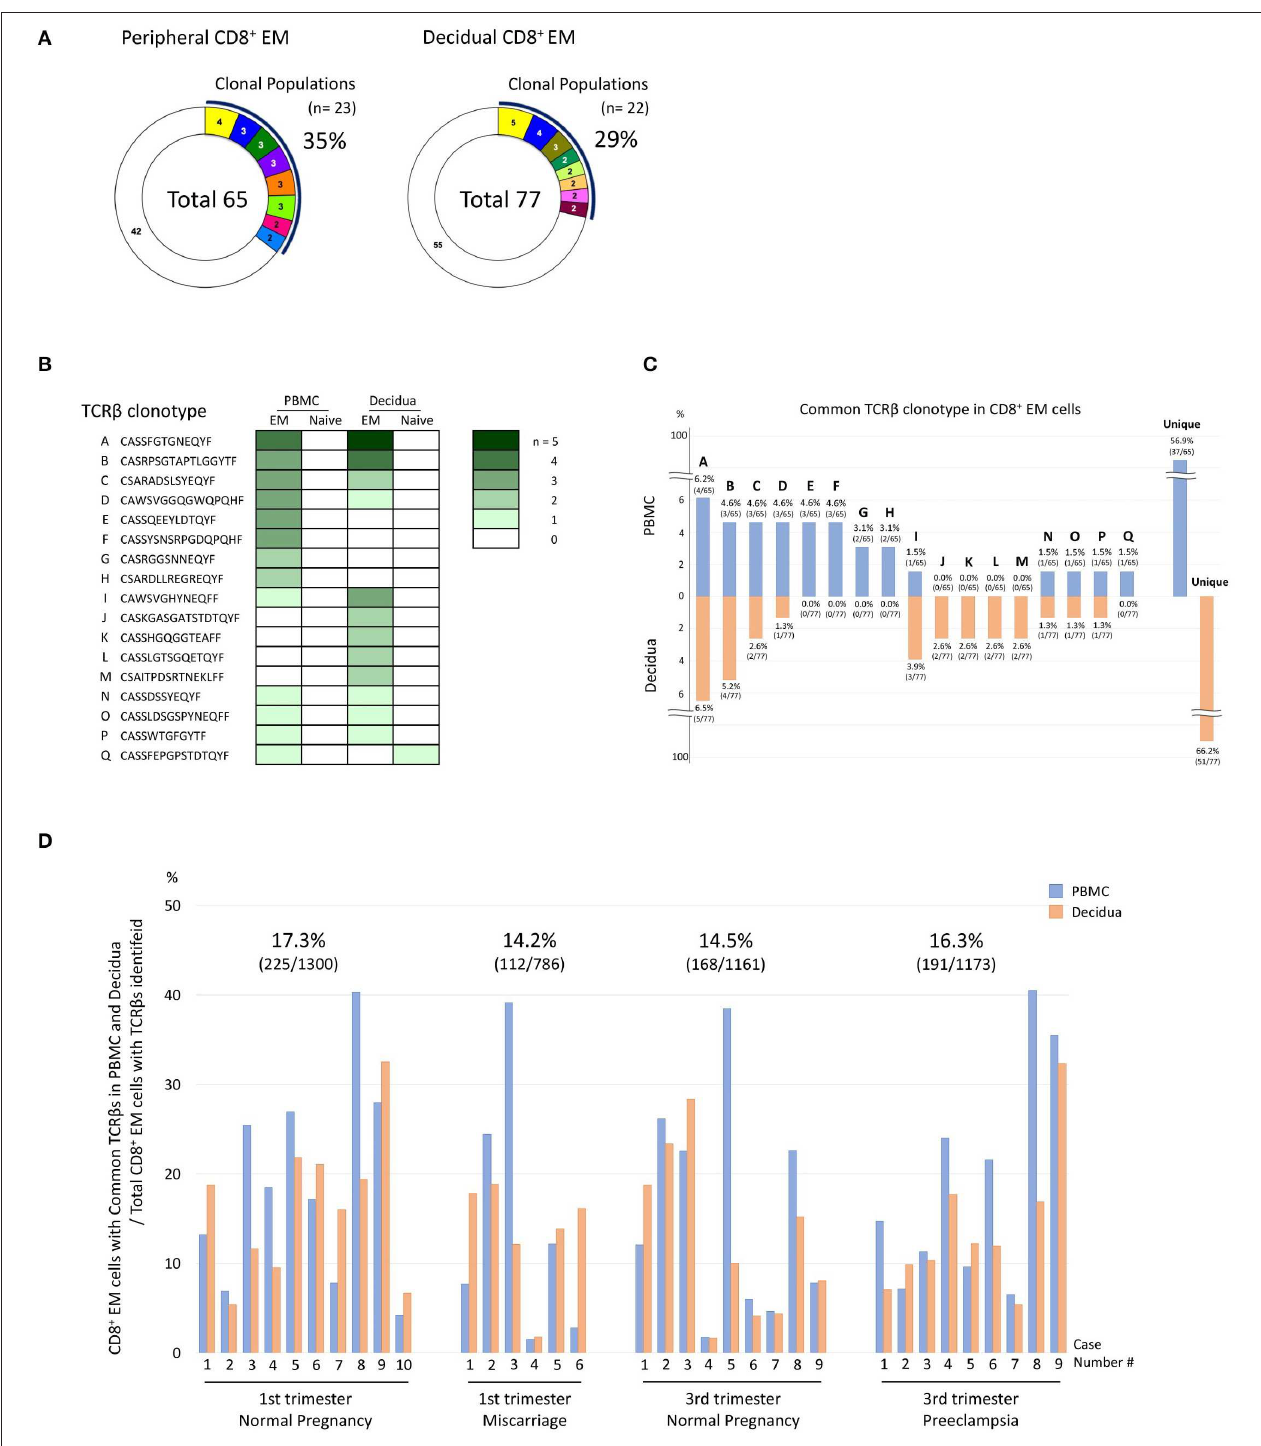
FIGURE 3 | Comparison of TCR β clonotype between PBMC and decidua. (A–C) A representative example of normal late pregnancy (case number #2). (A) Analysis of the TCR β repertoire in peripheral CD8 + EM cells (pCD8 + EM cells) and decidual CD8 + N cells (dCD8 + N cells). Each pie slice in color indicates the T-cell population expressing the same clonotypic TCR β . The numbers of CD8 + T cells expressing the same TCR β are shown in the pie charts. The white slice in each pie chart indicates the T cell population with unique TCR. The number in the center of the pie charts is the total number of analyzed T cells. The proportion of clonal cells was calculated as follows: clonal population (%) = clonal CD8 + T cells/total CD8 + T cells analyzed. (B) The TCR β clonotypes were compared between pCD8 + EM,